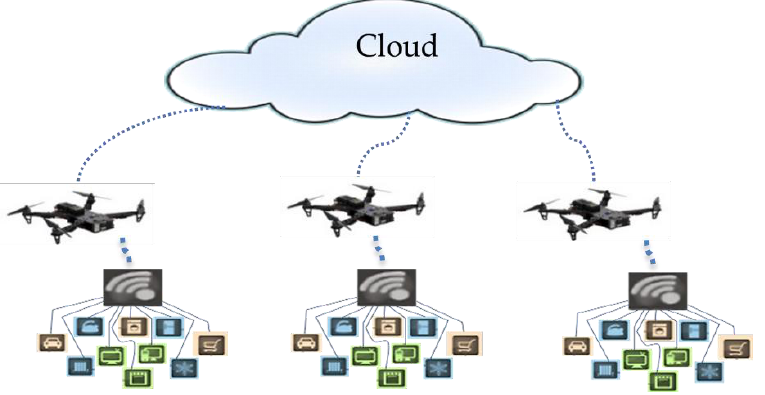
Figure 3. UAVFog supporting IoT applications.